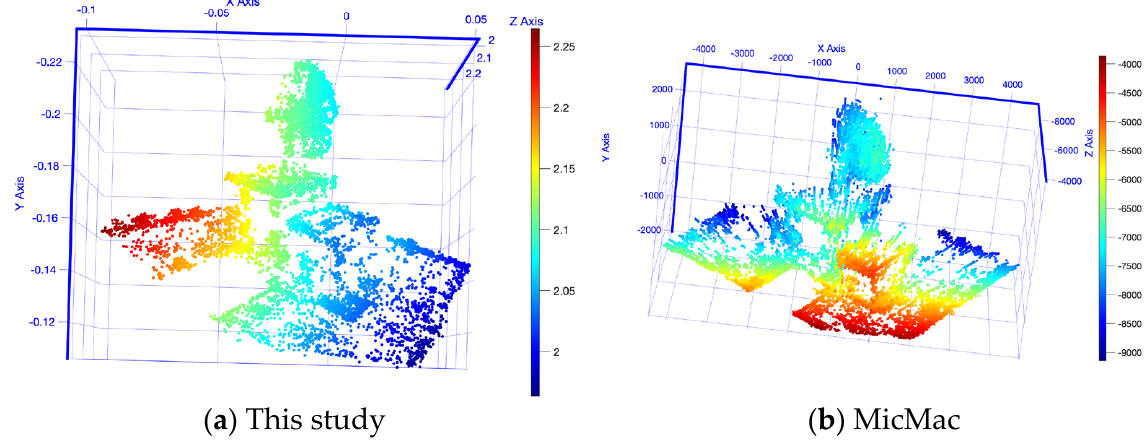
( b ) MicMac Figure 14. Histogram of the density evaluation of a small shift on the reconstruction in Cloud- Compare. The results of the 3D reconstruction shown in Figure 15 are generated with an in- creased baseline and camera angle. MicMac, again, generated a denser point cloud than our approach. MicMac generates a point cloud with 203,122 points, whereas our ap- proach has 9666 points. In contrast, MicMac needs many more images (Table 8) than the approach proposed in this study and as a result, much more time. Interestingly, the re- construction by MicMac and the approach proposed in this study is off in scale. This study-generated model is too small with an x-range of − 0.1 to 0.05, a y-range of − 0.12 to − 0.22 and a z-range of 2.2 to 2, whereas the MicMac-generated model is too big with an x-range of − 4000 to 4000, a y-range of − 2000 to 2000 and a z-range of − 4000 to